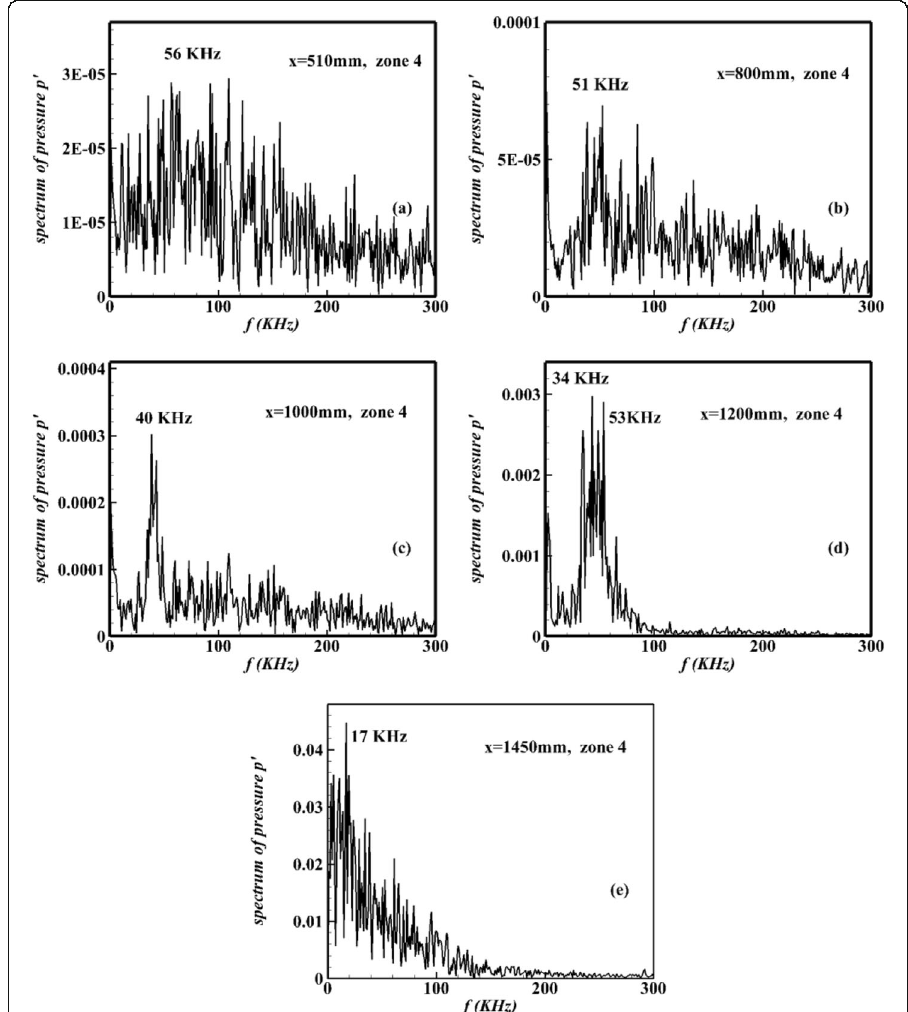
Fig. 20 Spectra of pressure fluctuations of zone 4; ( a ) x = 510 mm, ( b ) x = 800 mm, ( c ) x = 1000 mm, ( d ) x = 1200 mm, ( e ) x = 1450